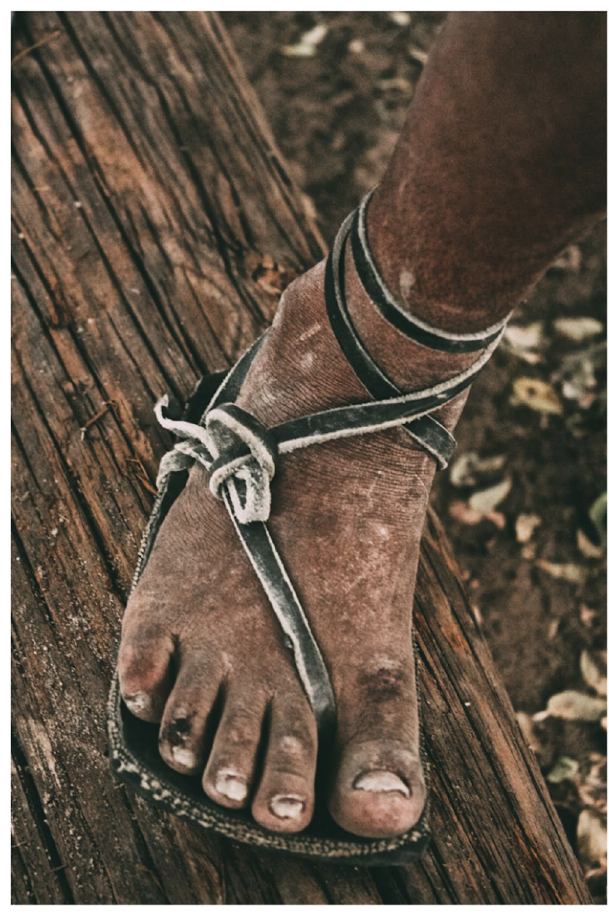
Figure 1. A Tarahumara man wearing a typical sandal with a sole made from car tire rubber. Photo copyright© 2018 by David Ramos and used here with permission. All rights